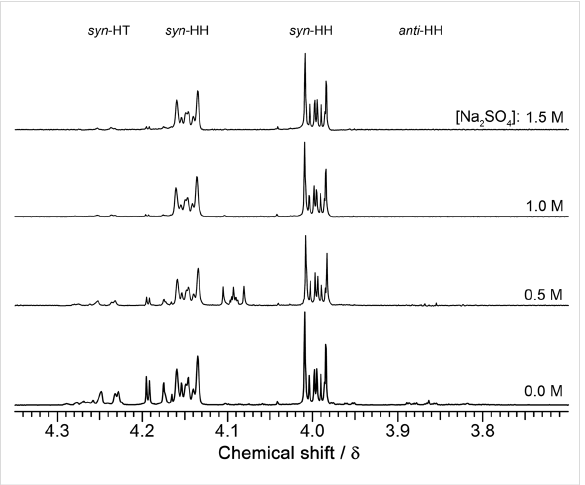
Figure 6: Partial 1 H NMR of the photodimers formed after irradiation of COU at various concentrations of Na 2 SO 4 in the presence of 6 mM γ -CD thioether 2